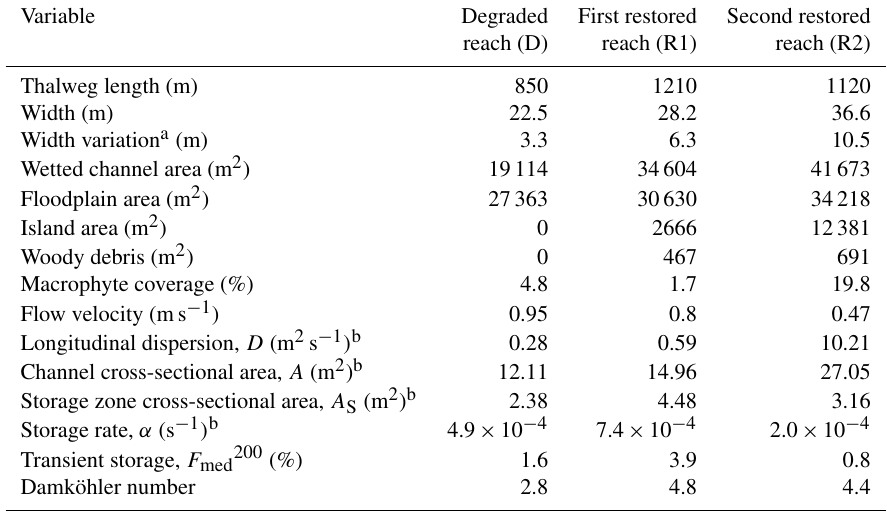
Table 2. Morphological and hydrodynamic characteristics of the investigated river reaches. Variable Degraded